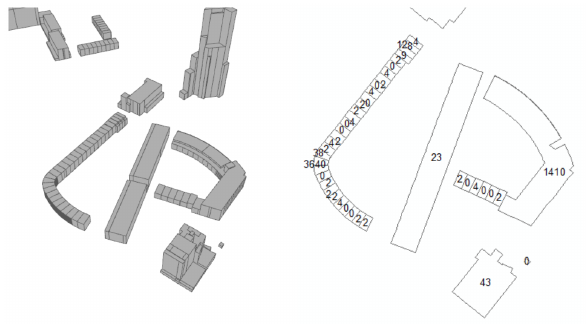
Figure 4. Curved surfaces represented by multiple short straight segments in